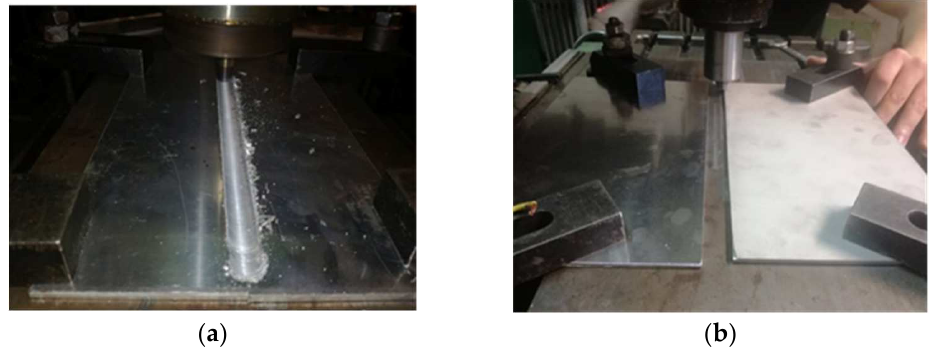
Figure 4. ( a , b ) Images with the steps of the joint making.